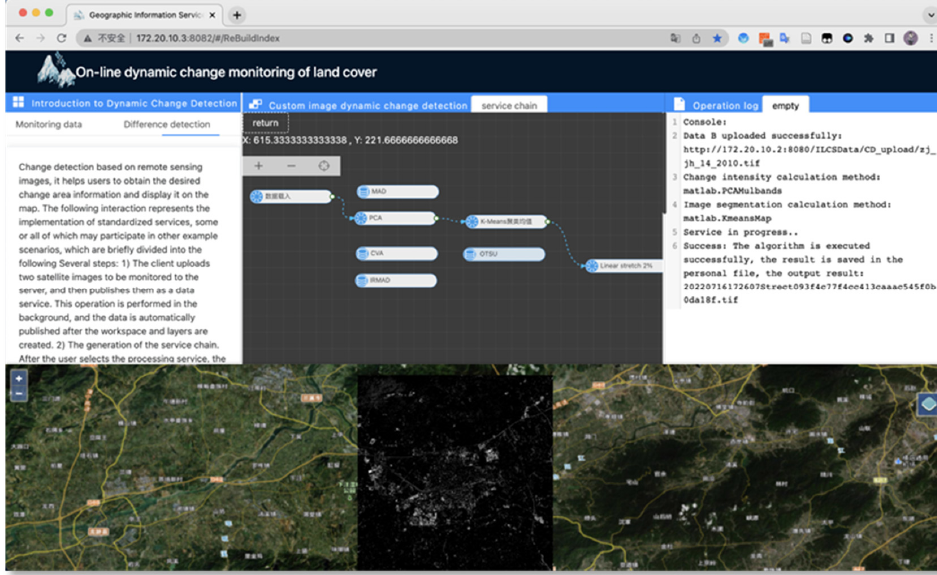
Figure 6. Graphical user